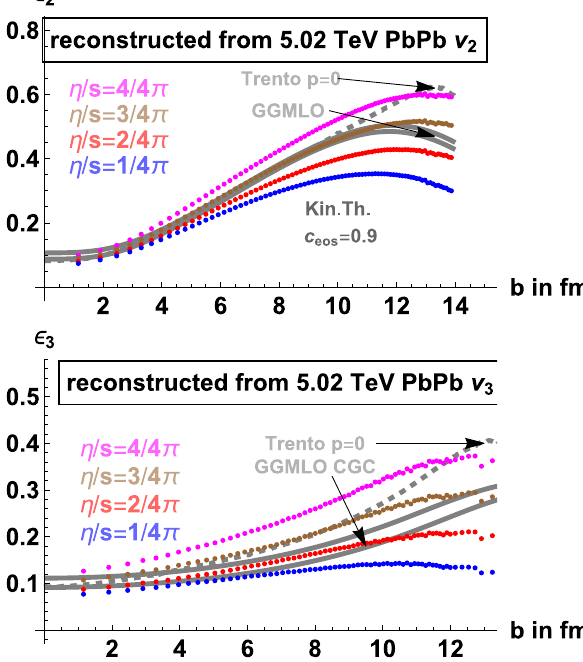
Fig. 14 The eccentricities (cid:17) 2 and (cid:17) 3 preferred by kinetic theory with c eos according to (41) and compared to two eccentricity models of Ref.